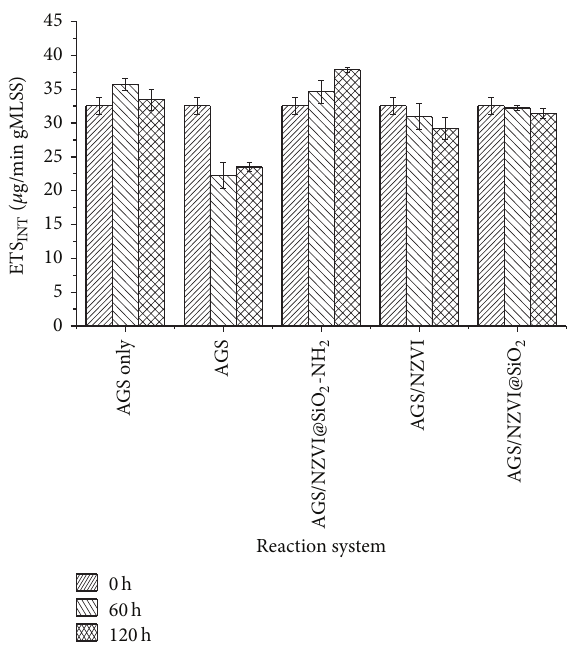
Figure 8: The changes of ETS INT of the anaerobic granule sludge under different concentrations of NZVI@SiO 2 -NH 2 before and after being exposed to